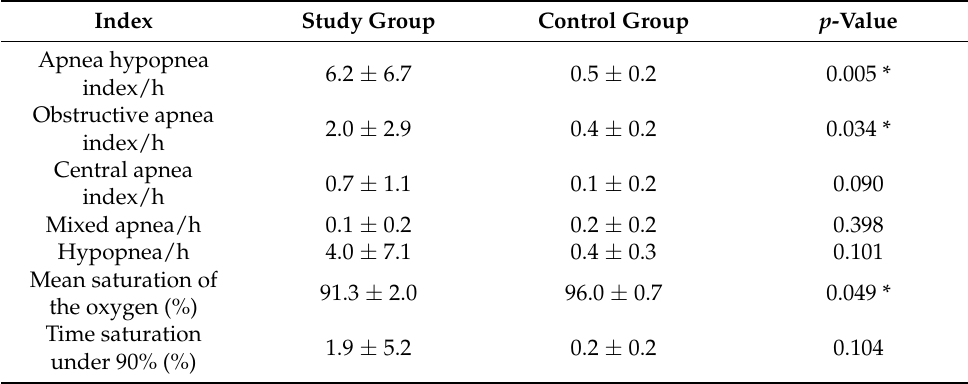
Table 3. Mean value of the nocturnal polygraphic cardiorespiratory monitoring.